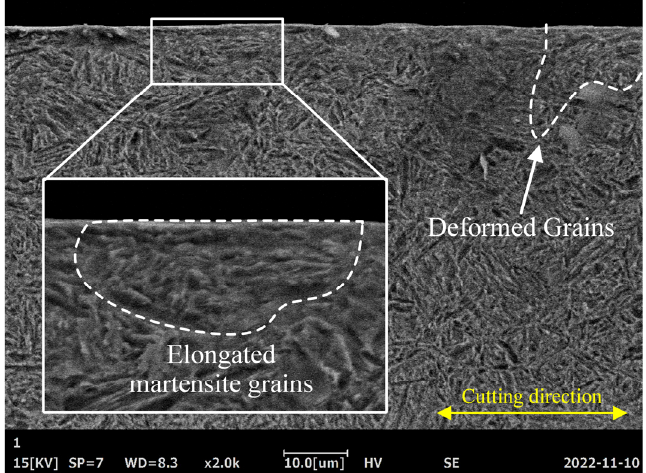
Figure 11. Typical morphology of the microstructure in the subsurface layer after grinding with a feed speed of 0.4 m/s and cutting depth of 0.03